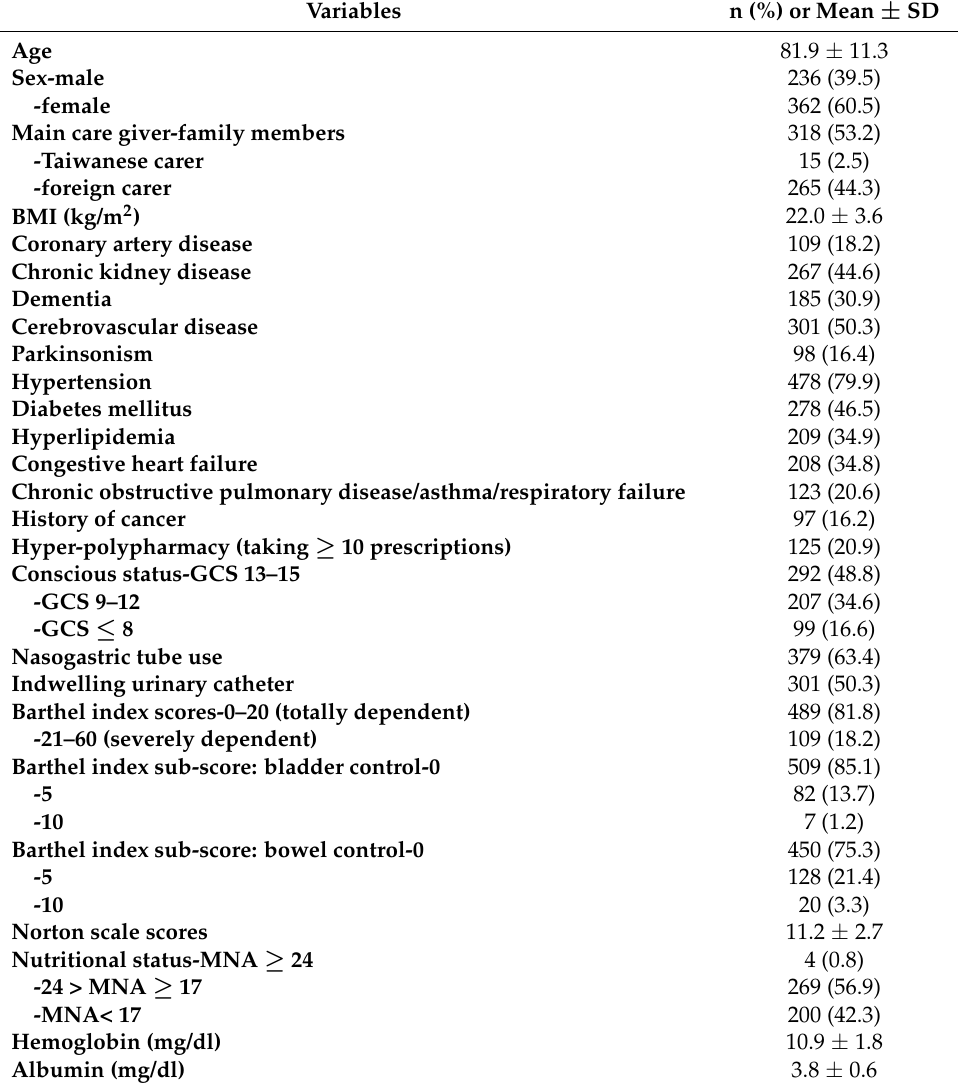
Table 1. Basic characteristics of the study population (N =